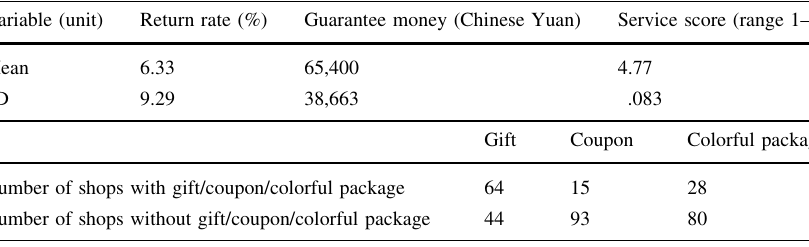
Table 8 Descriptive statistics of the valid sample in Study